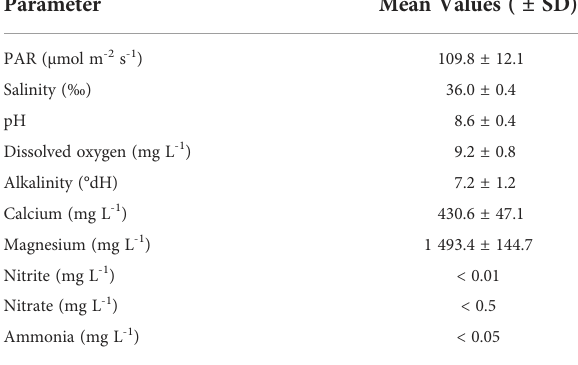
TABLE 1 Mean values (± SD) of water quality parameters maintained in the tower system throughout the experiment (excluding PO 43 - concentrations and